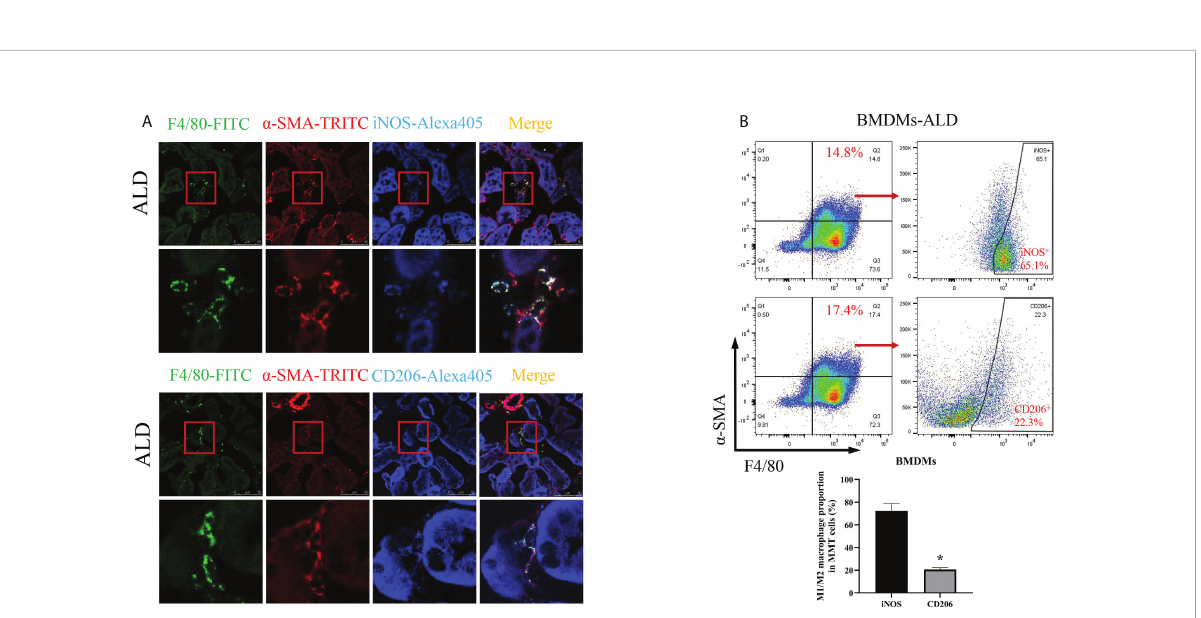
FIGURE 5 M1 macrophages were the major subtype associated with MMT in the kidneys of UNX+ALD-infused mice and ALD-treated BMDMs. (A) Fluorescence costaining of F4/80 (green) and a -SMA (red) with the M1 macrophage marker iNOS (blue) or the M2 macrophage marker CD206 (blue). (B) Flow cytometric analysis of the expression of F4/80, a -SMA, and iNOS or CD206 in ALD-treated BMDMs. The data are presented as the mean ± SD, *p < 0.05 vs. iNOS. MMT, macrophage-to-myo fi broblast transition; UNX, uninephrectomy; ALD, aldosterone; BMDMs, bone marrow-derived